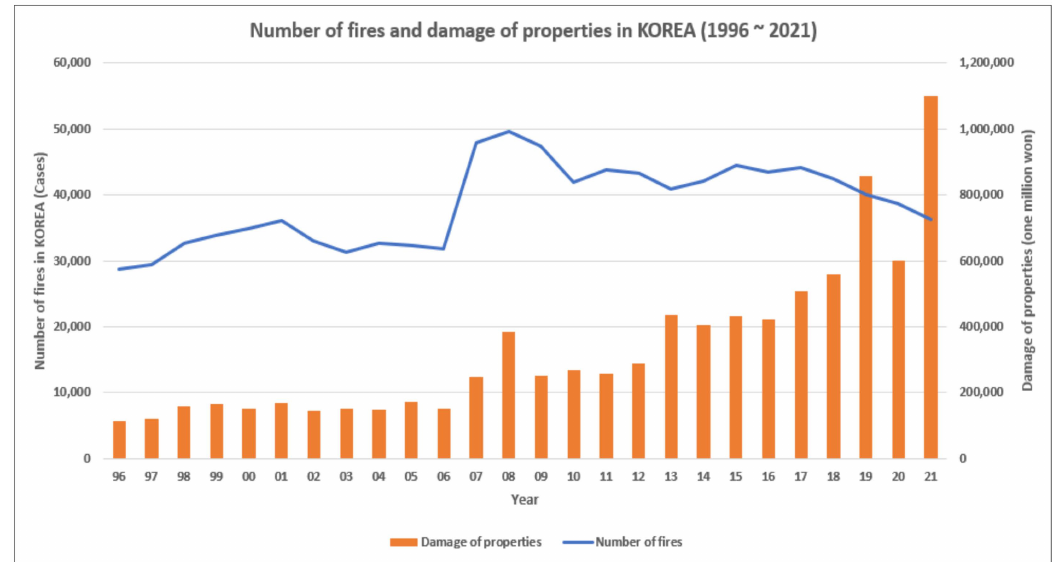
Figure 2. Number of fires and property damage amount in ROK (1996–2021).